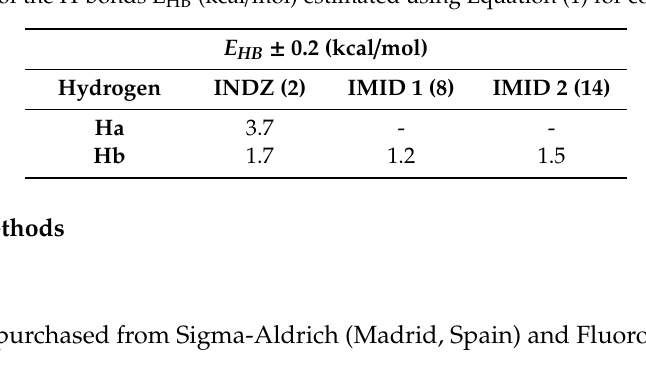
Table 7. Energy of the H-bonds E HB (kcal / mol) estimated using Equation (1) for compounds 2-8-14